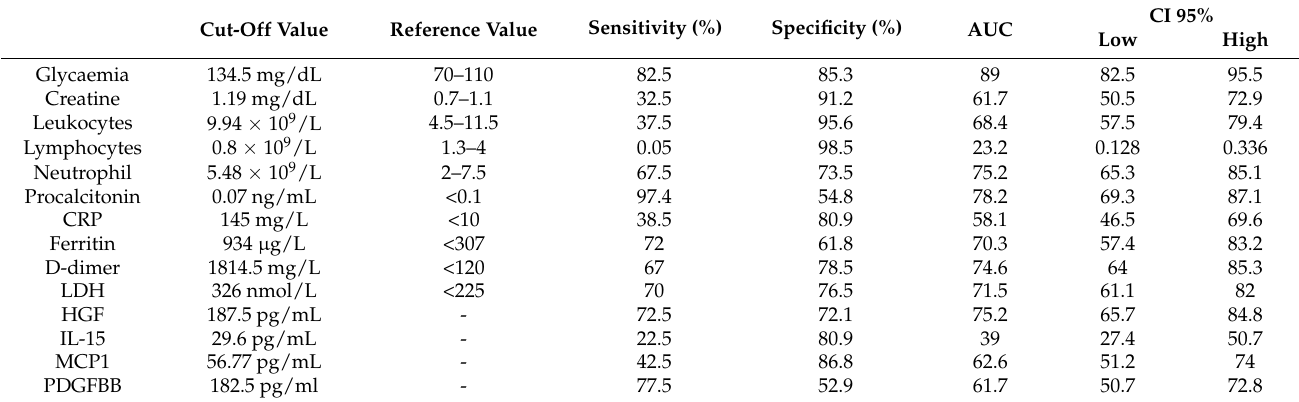
Table 2. Estimation of the cut-off value of the significant analytical variables by ROC curve. Cut-Off Value Reference Value Sensitivity (%) Glycaemia